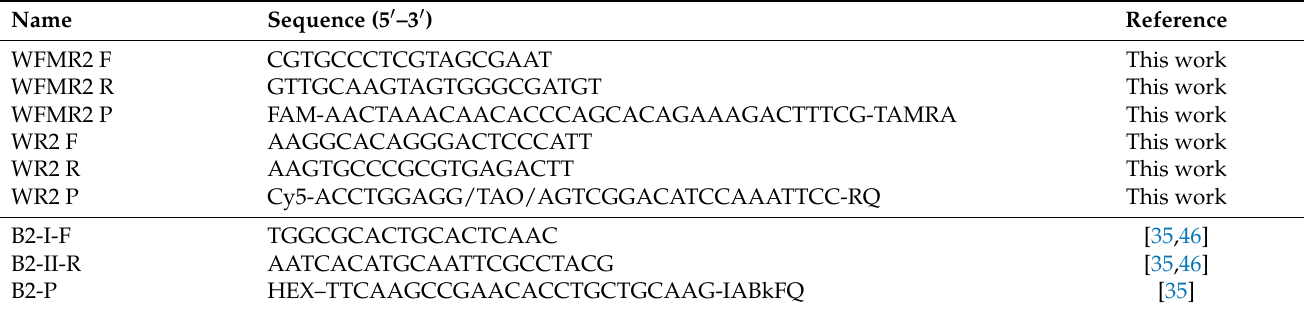
Table 1. Sequences of primers and probes for Ralstonia solanacearum phages vRsoP-WF2, vRsoP-WM2, and vRsoP-WR2, and the bacterial species R. solanacearum